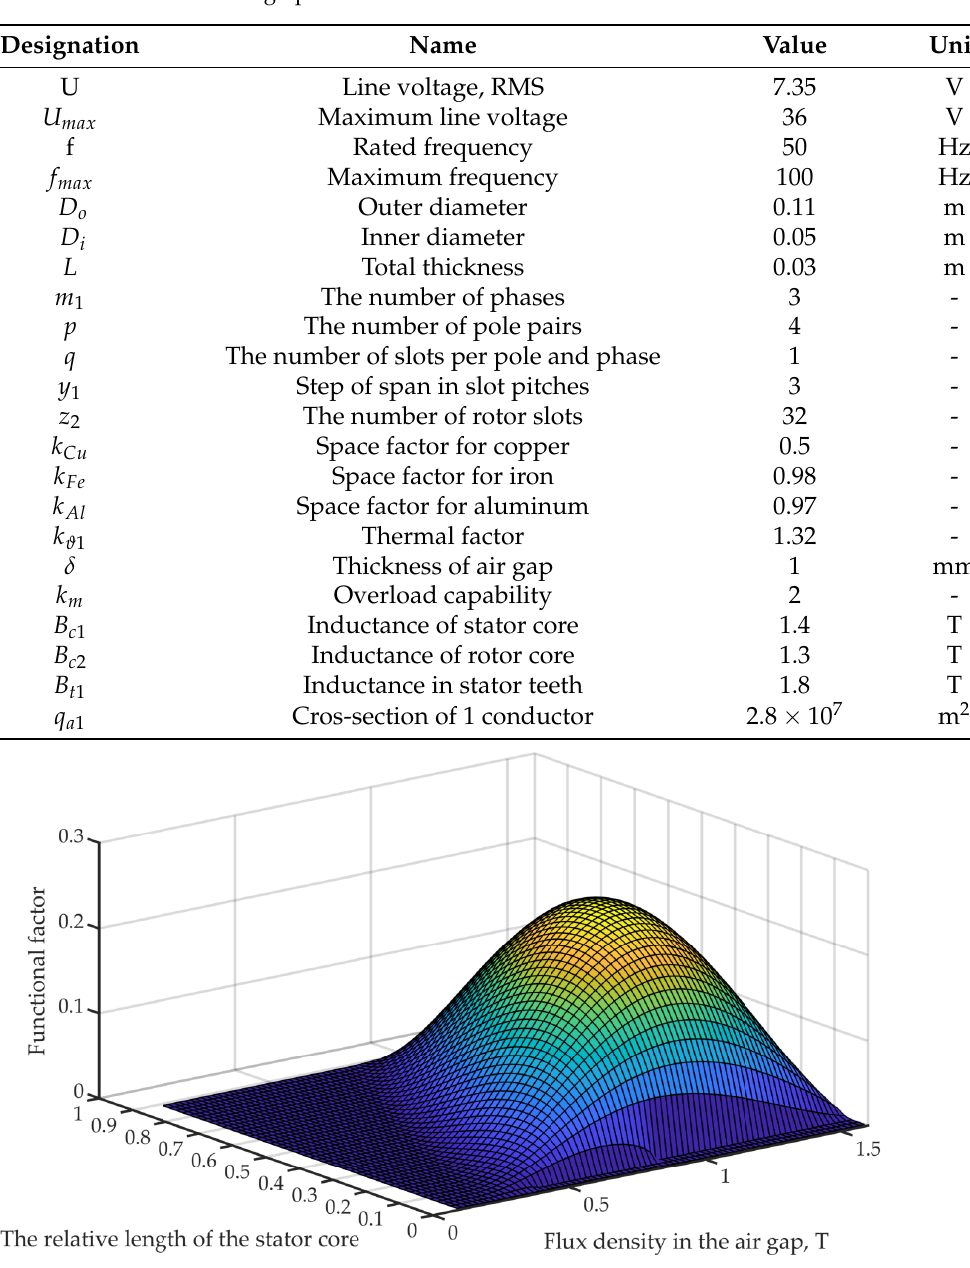
Table 1. Initial data of design process.